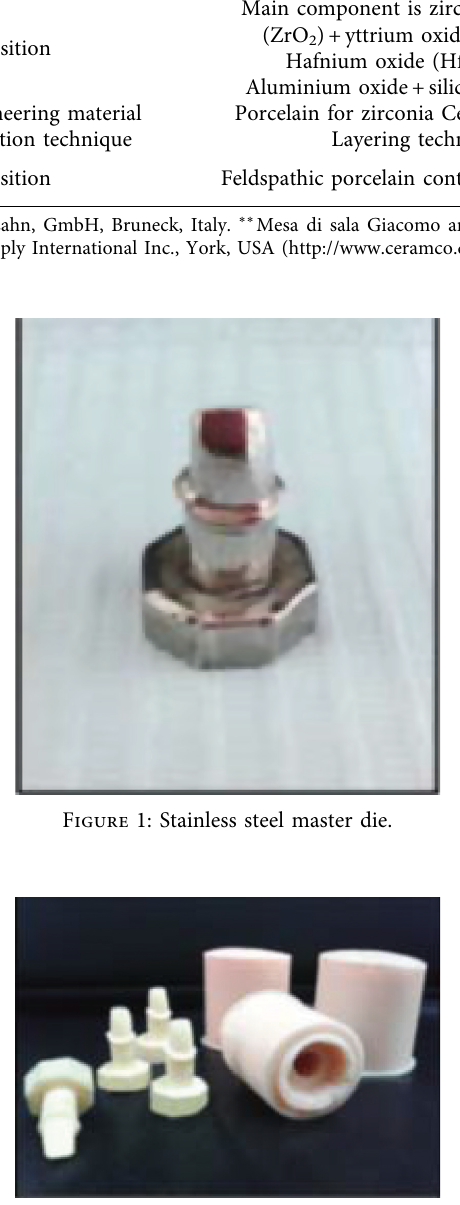
Figure 2: Epoxy resin replicas of master die.